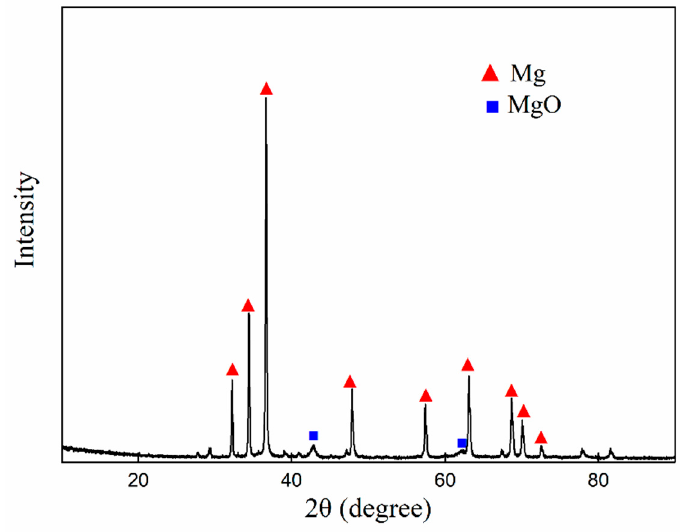
Figure 5. XRD pattern of CNTs/Mg composites after hot pressing sintering.